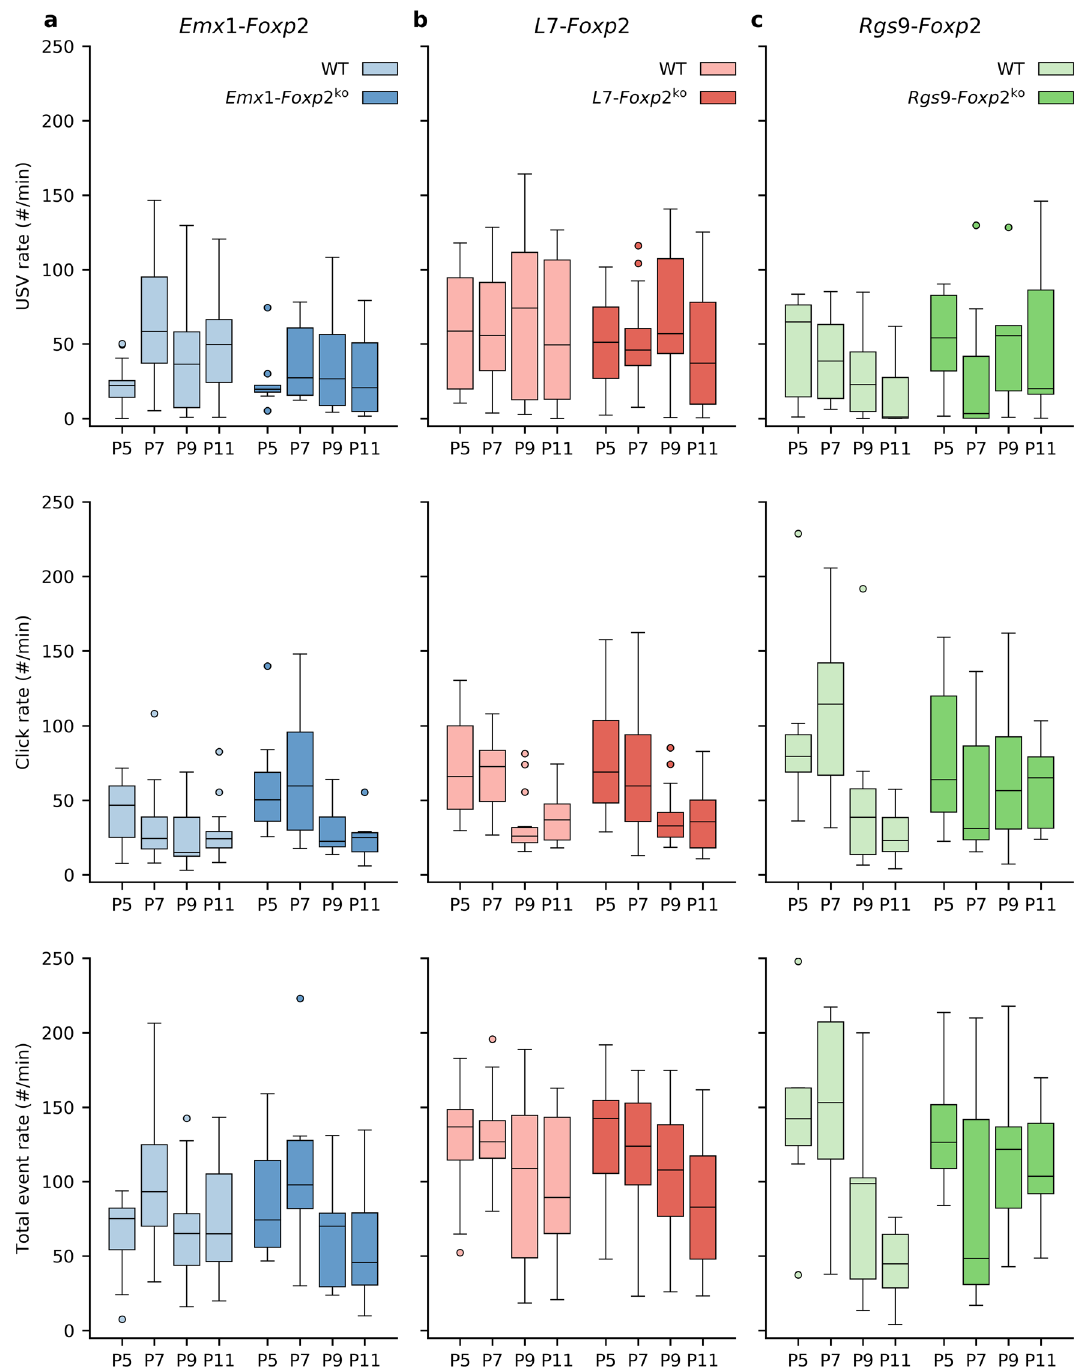
Figure 2. Call rates in the three conditional knockout groups are unaffected. Top row: USV rate in calls per minute for the three conditional knockout groups. WT mice and mutants are not significantly different in any of the groups. Middle row: click rate in clicks per minute. Mutant animals do not significantly differ from their WT littermates. Bottom row: event rate as the sum of USVs and clicks per minute. No effect of genotype was found on any measure for either the Emx1-Foxp2 ( a ), L7-Foxp2 ( b ), or Rgs9-Foxp2 ( c ) mice. Click rates and USV rates are unaffected. In this and all following boxplots, the center line of the box indicates the median, whereas the top and bottom edges of the box indicate the 75th and 25th percentile respectively. The whiskers indicate 1.5 × IQR, and individual points are outliers. Y-axes scaling is constant for each